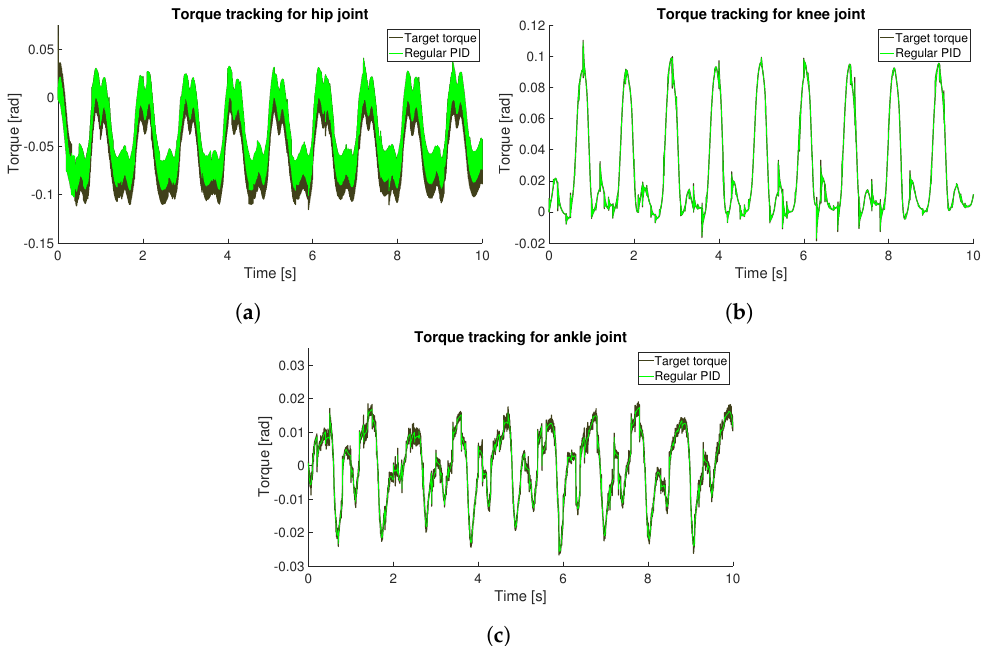
Figure 8. Comparison of the control evolution for the tracking problem based on the application of the PID controller (green) for the hip ( a ), knee ( b ) and ankle ( c